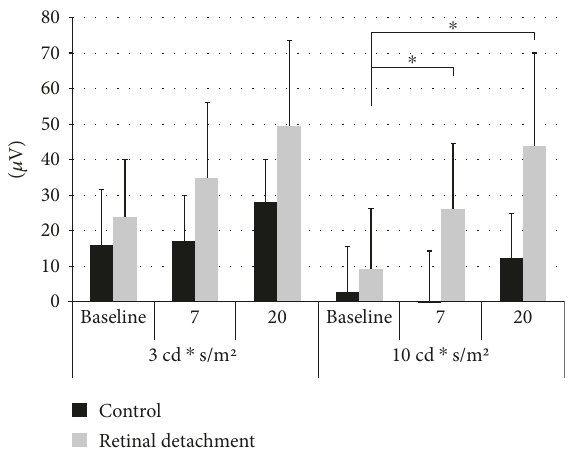
Figure 6: Mean ± SD amplitude di ff erences between the b-wave and WDS peaks at three timepoints: preoperatively and 7 and 20 days postretinal detachment ( n = 10 ). Considering all timepoints and fl ash intensities, the di ff erence between the experimental and control eyes was signi fi cant (ANOVA with repeated measures, p < 0 05 ). Speci fi cally, a signi fi cant increase in the WDS di ff erence of RD eyes in response to the higher fl ash intensity was found, meeting the Bonferroni criterion ( p < 0 016 ) at both 7 and 20 days postprocedure ( ∗ ). RD=retinal